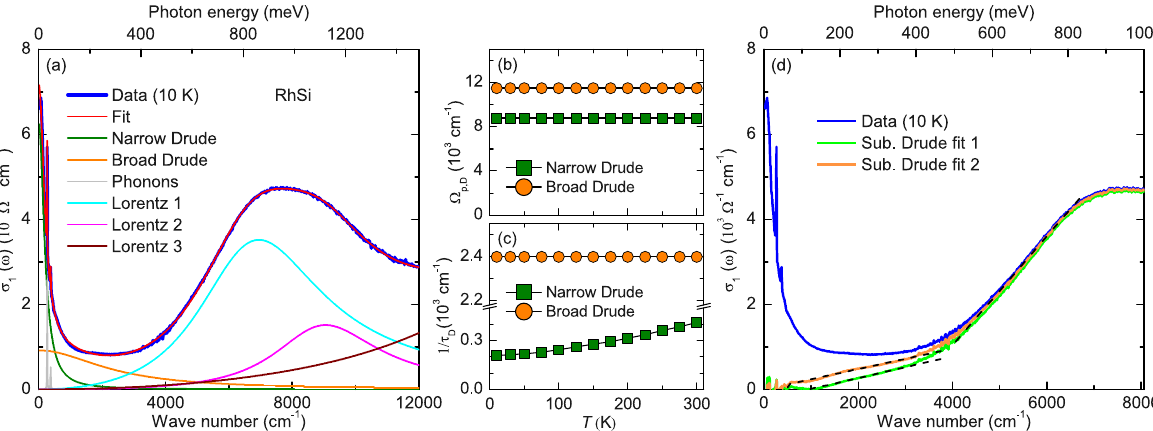
Fig. 2 Drude and interband optical responses in RhSi. a Optical conductivity spectrum of RhSi up to 12,000 cm − 1 (1.5 eV) at 10 K. The thin red line through the data is the Drude – Lorentz fi tting result, which consists of the contributions from a narrow Drude peak (green line), a broad Drude peak (orange line), and several Lorentz terms that accounts for the phonons (gray) and the interband transitions (light blue, magenta, and wine lines). Temperature dependence of b the plasma frequency Ω p,D and c the transport scattering rate 1/ τ D of the Drude terms. d Optical conductivity spectrum of RhSi at 10 K, and the corresponding spectrum after the Drude response and the sharp phonon modes have been subtracted. Black dashed lines are eye guidance for different quasi-linear